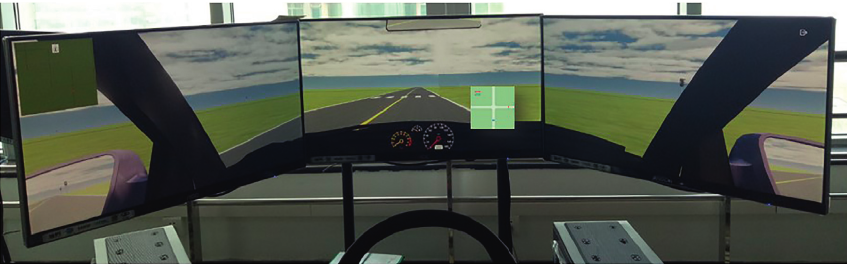
Figure 5: Display of the driving simulator and the warning interface.